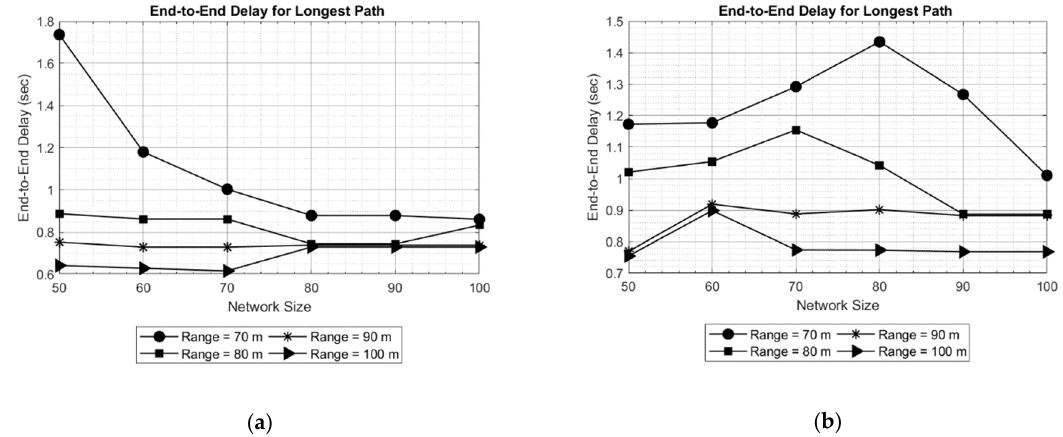
Figure 20. End-to-end delay for longest path fortwo particular simulations: Test 1 ( a ) and Test 2 ( b ).